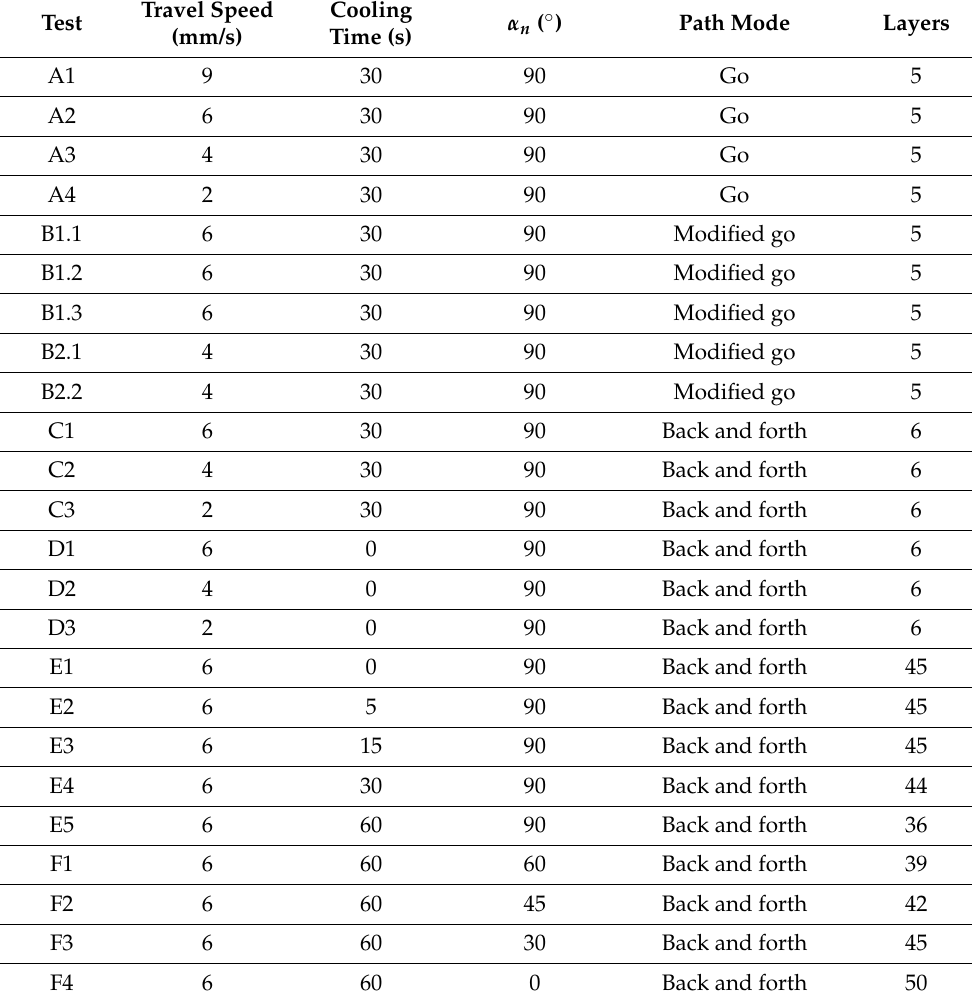
Table 2. Experimental plan of the A–F